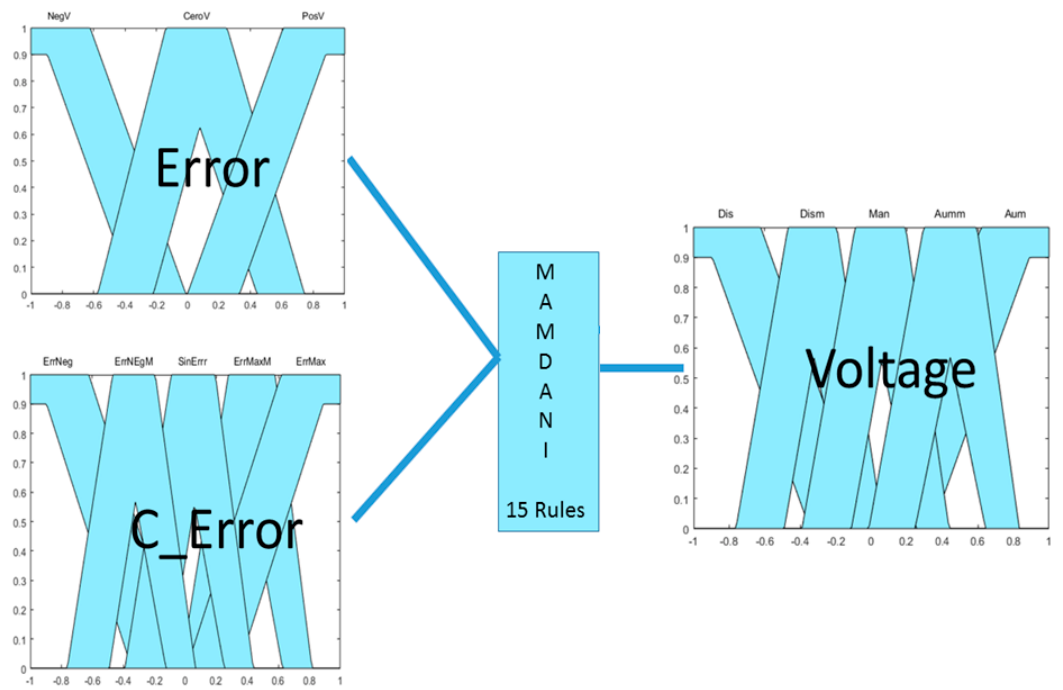
Figure 4. Interval type-2 fuzzy system for DC motor. Table 4. Fuzzy rules for the motor controller.